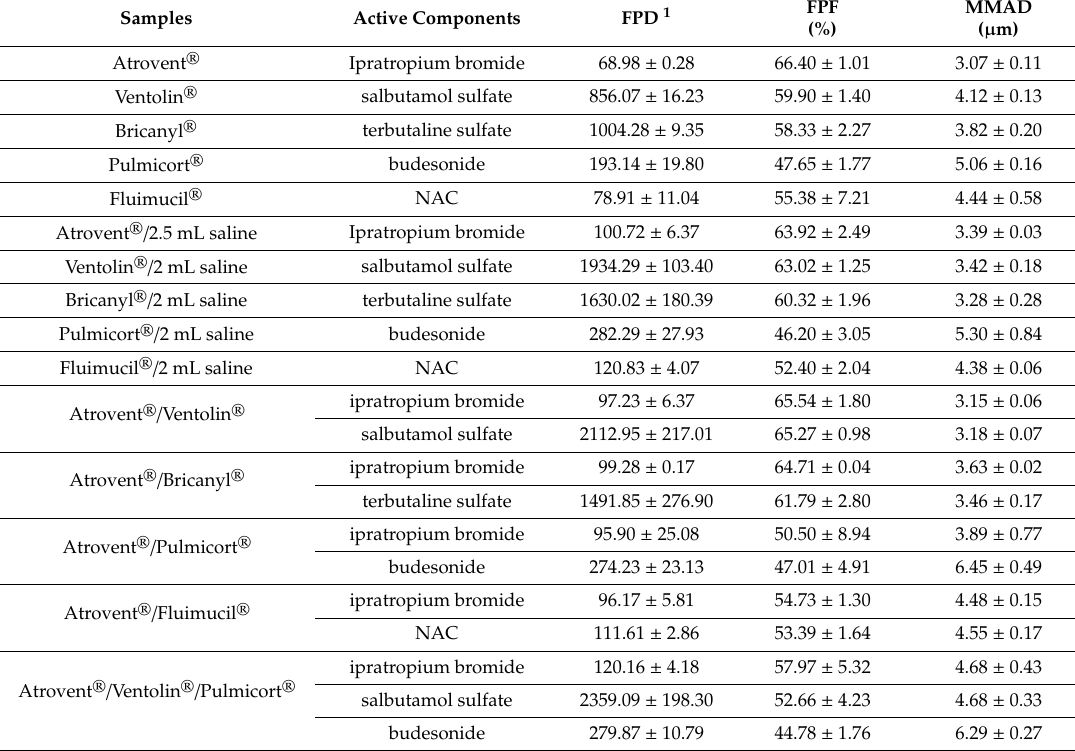
Table 4. FPD, FPF, and MMAD of test